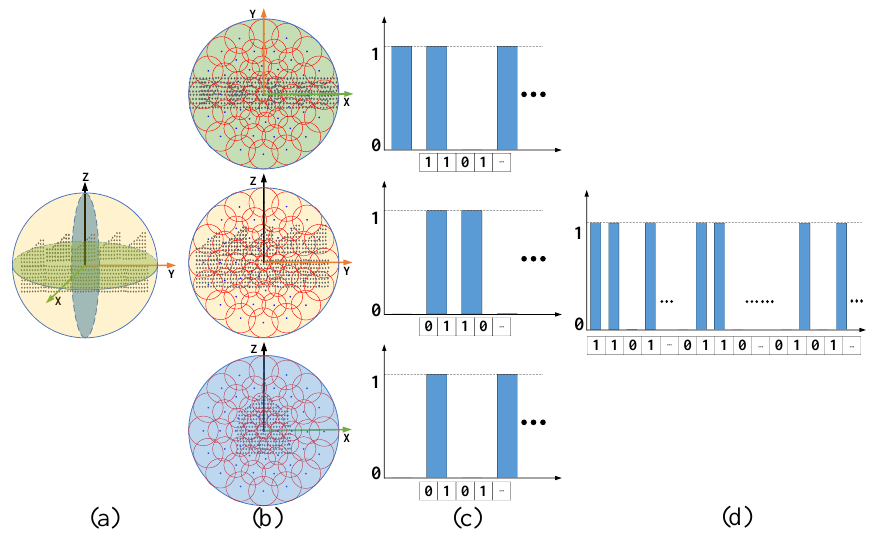
Figure 2. Schematic diagram of the point cloud feature extraction method based on retina-like sampling on projection planes. ( a ) Local point cloud; ( b ) Sampling mode of retina-like sampling on each projection plane; ( c ) Sub binary feature histograms; ( d ) Fused binary feature histogram. The schematic diagram of the retina-like sampling mode designed in this paper is shown in Figure 3.